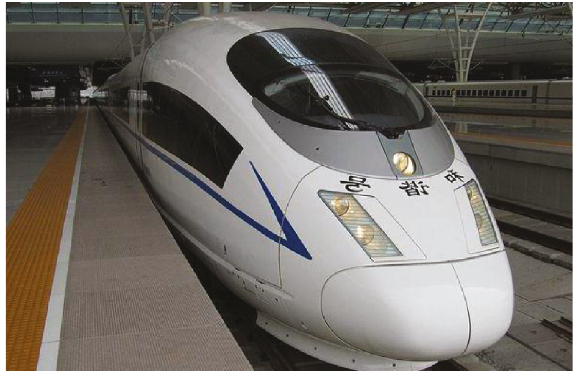
Figure 3: The referential CRH3 high-speed train.